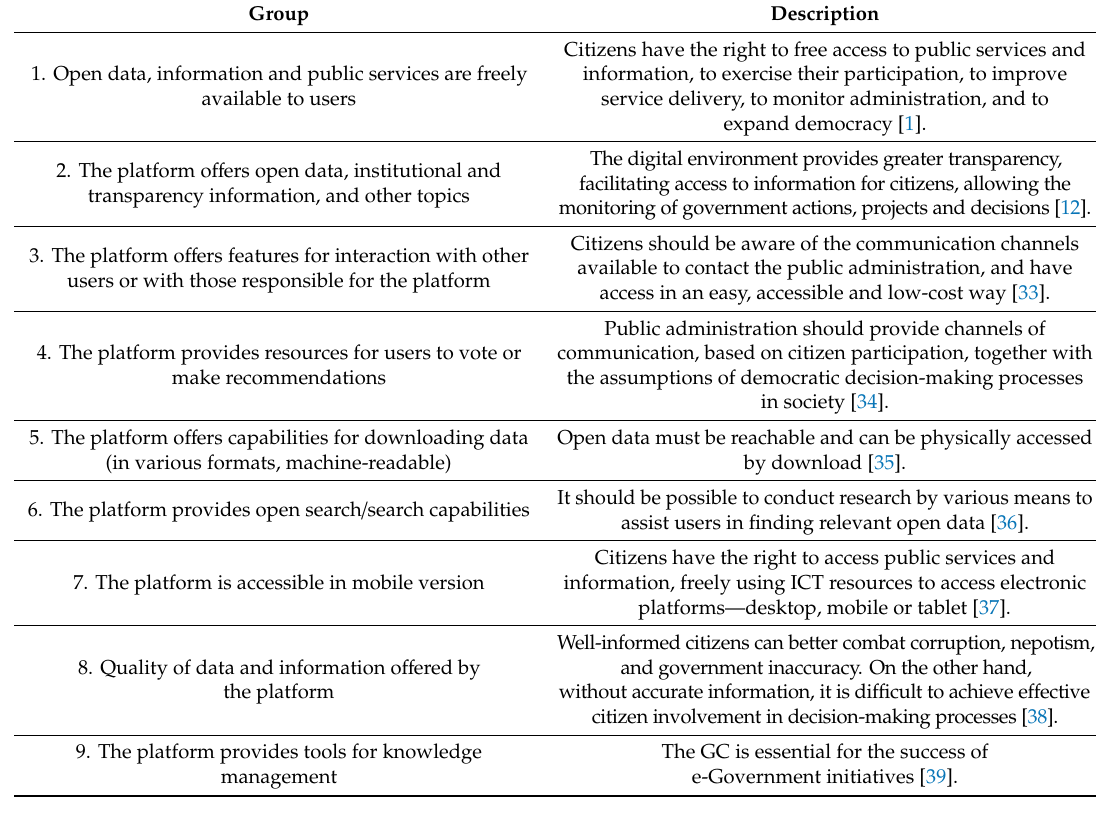
Table 4. Item groups and their description.